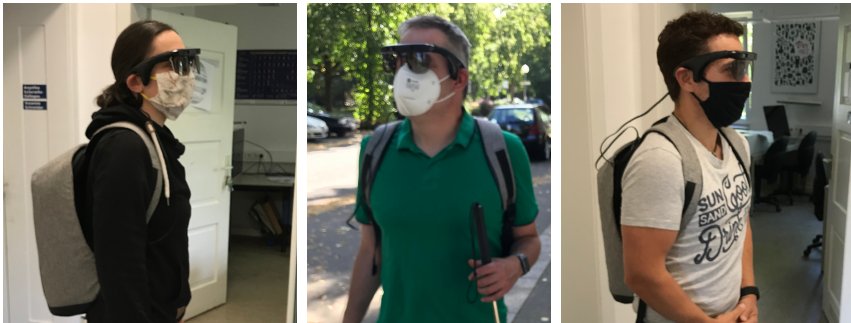
Figure 2. Incidences of participants using the system to maintain social